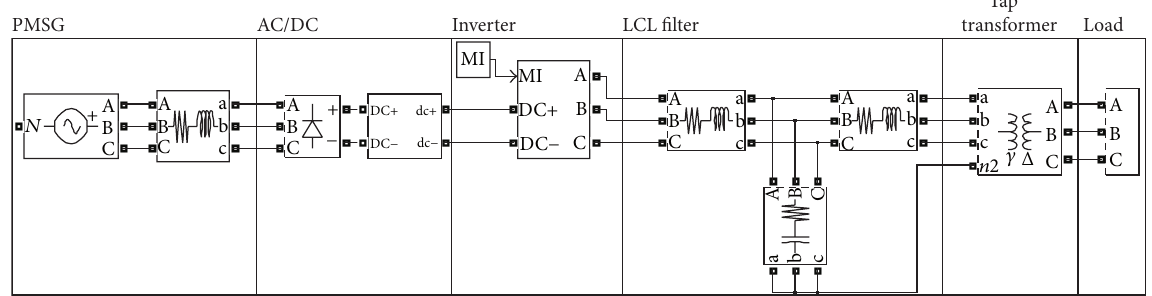
Figure 7: Simulink model of the tap transformer based grid connection system. The generator is to the left followed by the passive diode rectifier, IGBT based inverter, LCL-filter, and one tap of the tap transformer connected to a resistive load.